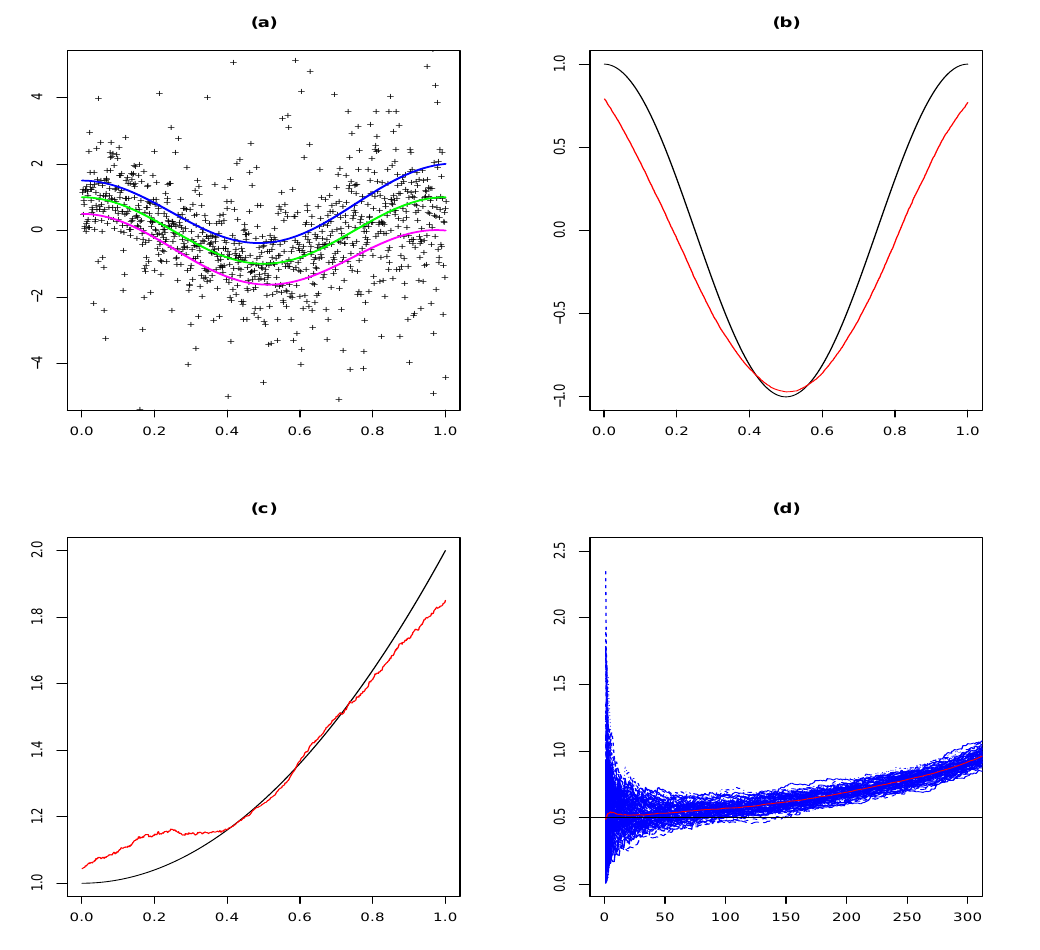
(·) (red). (c): Scale function b (·) (black) and n